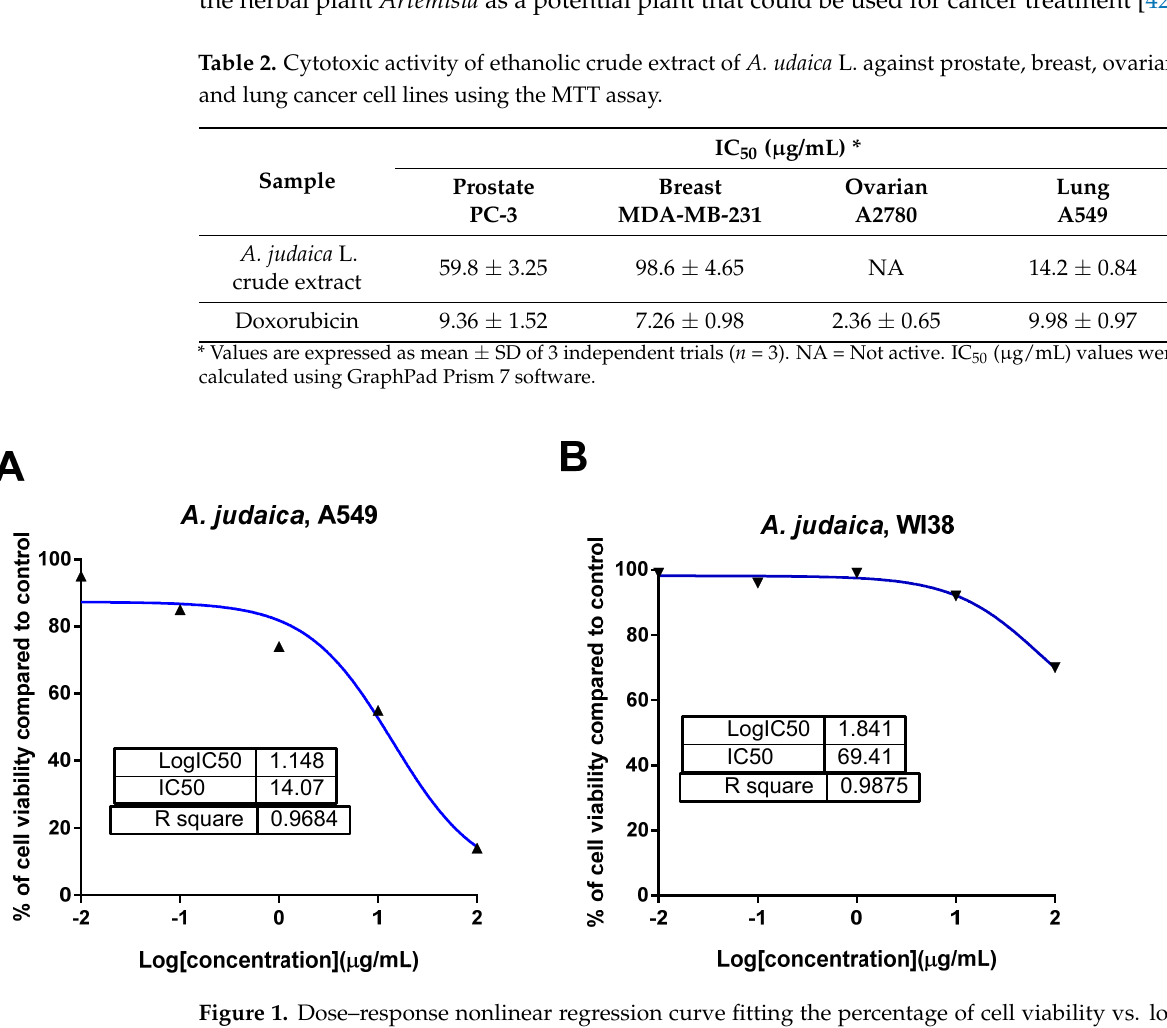
Figure 1. Dose–response nonlinear regression curve fitting the percentage of cell viability vs. log [con. µ g/mL], R square ≈ 1 using the GraphPad prism software. ( A ): cytotoxicity against lung cancer A549 cells, and ( B ): cytotoxicity against normal lung WI38 cells.